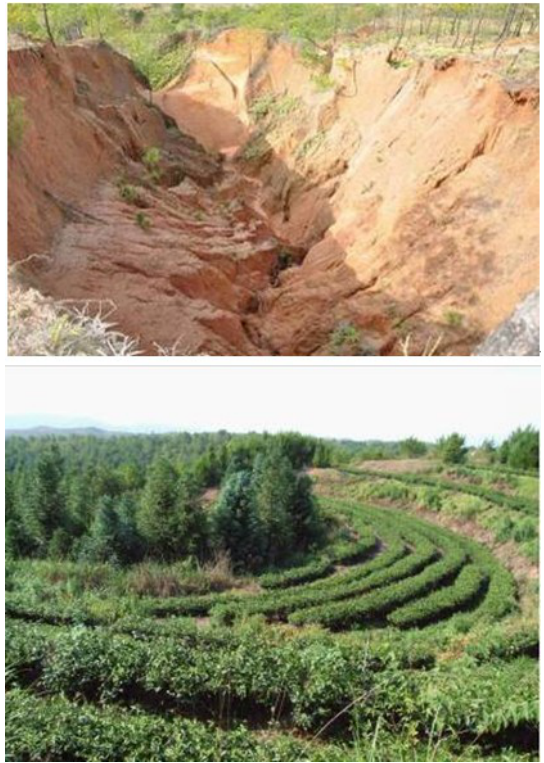
Fig. 4 . The slope collapsed when vegetation could not reduce runoff and protect the soil (Top). Successful stabilization of the slope after nine years (Bottom; Zhong et al.